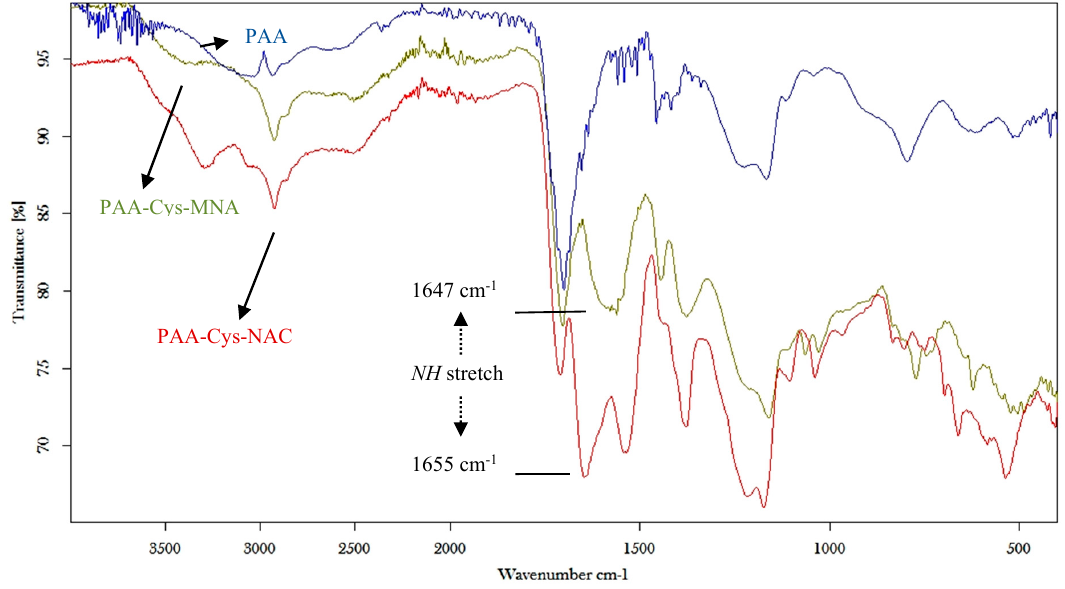
Figure 4. FT-IR spectra of unmodified PAA, PAA-Cys-MNA and PAA-Cys-NAC.